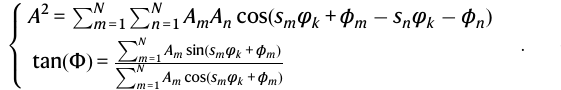
phases (in tangent) are fi tted simultaneously. The overall fi t for each set is repre- sented in the color that matches the polarization of the corresponding microwave pulse whose phase was varied in the experiment. The gray line in each panel is the simulated amplitude or phase by excluding the M6WM component from the complete fi t as discussed in the main